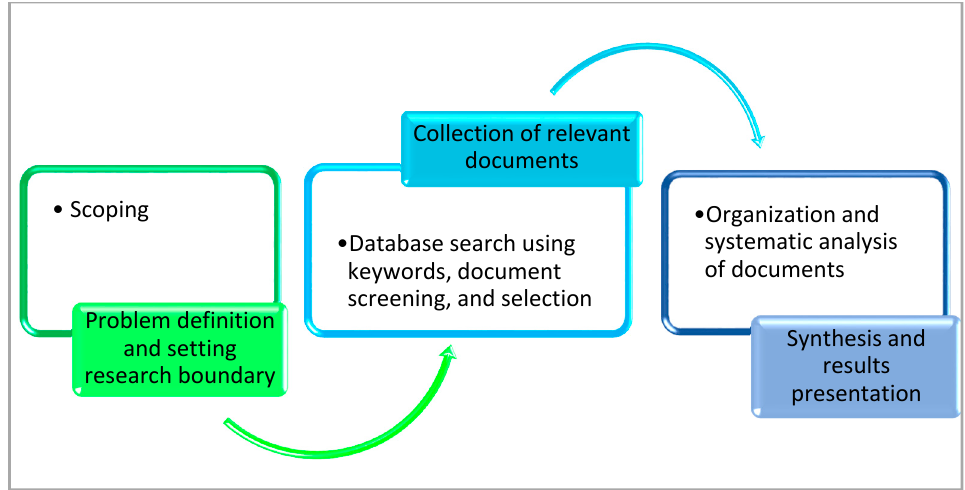
Figure 3. Research methodology flow chart (developed by authors).